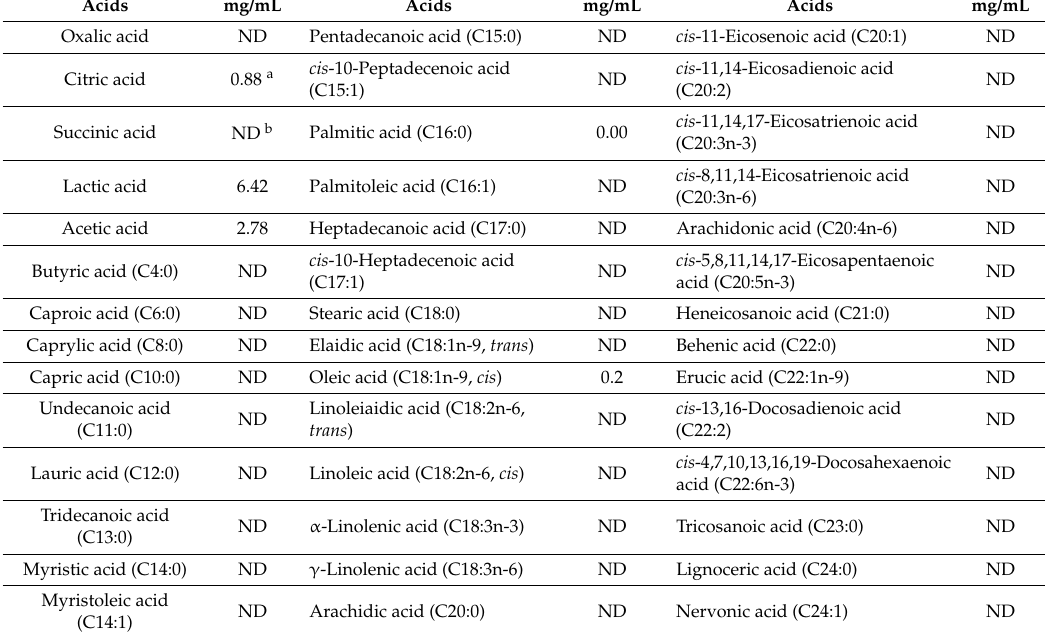
Table 1. Quantitative analysis of organic and fatty acids in the CFS of oraCMU after 16 h incubation at 37 ◦